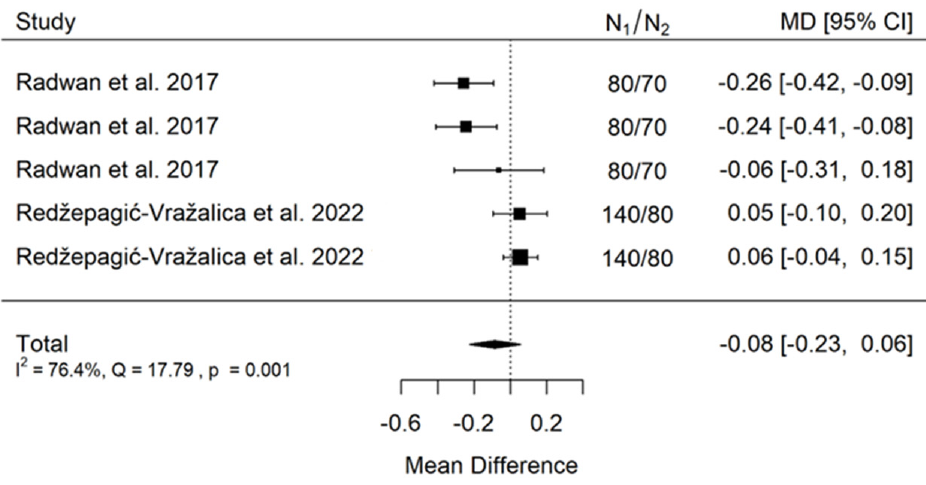
Figure 8. Forest plot for evalutaion of thread depth dimension infulence on pull-out strentght in animal bone model studies [38,44].